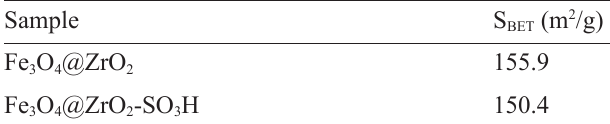
Table 2. Measured S BET of Fe 3 O 4 @ZrO 2 and Fe 3 O 4 @ZrO 2 -SO 3 H.